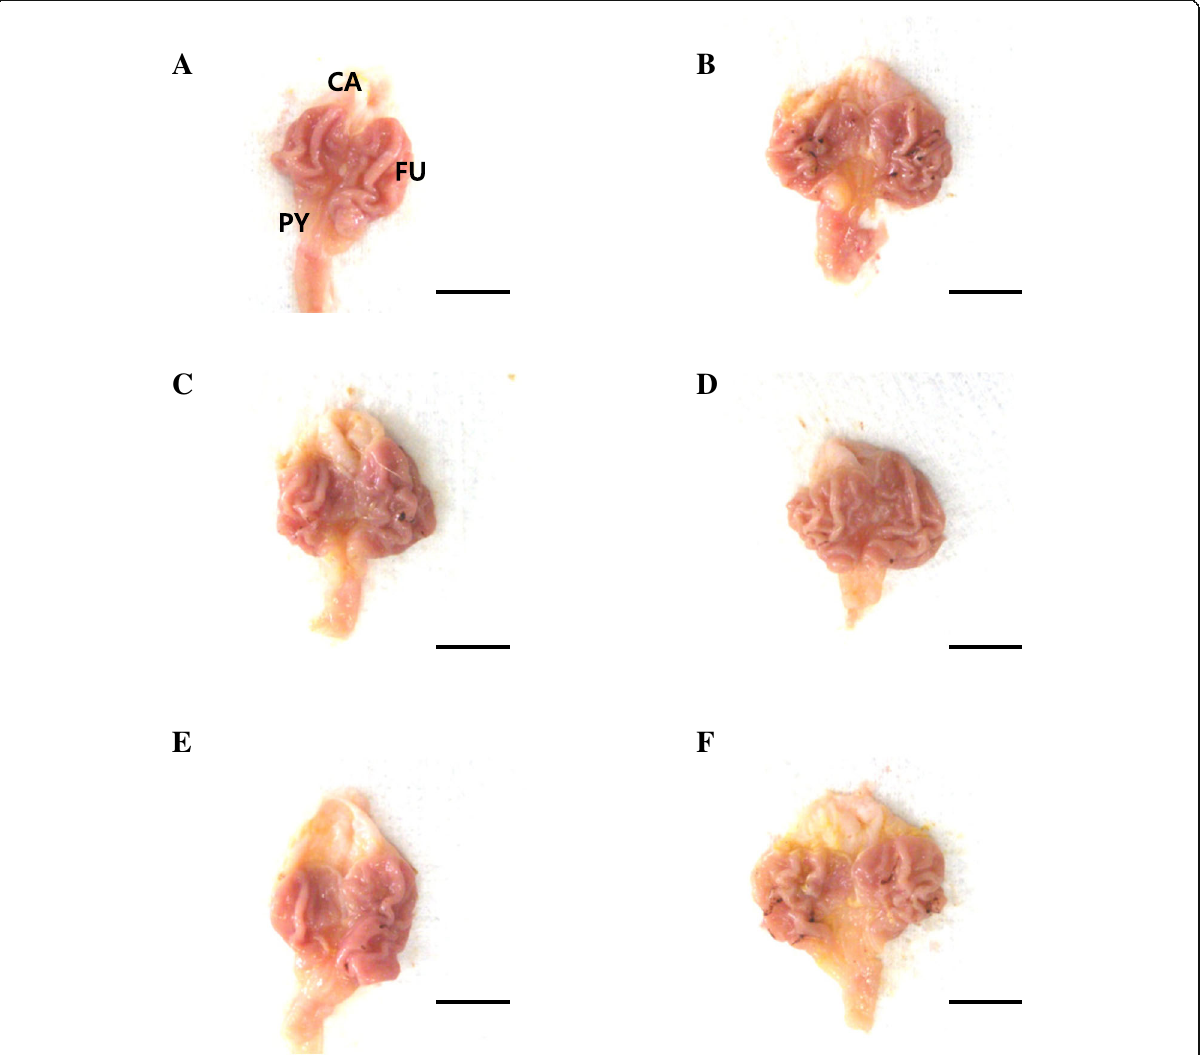
Fig. 2 Representative gross stomach images taken from intact or IND-treated mice. a : Intact control (DW 5 ml kg − 1 , twice administered rats with 30 min-intervals). b : IND control (DW 5 ml kg − 1 and IND 25 mg kg − 1 administered gastric mucosal damage induced vehicle control rats). c : OM (OM 10 mg kg − 1 and IND 25 mg kg − 1 administered reference drug treated rats). d : FBe 300 (FBe 300 mg kg − 1 and IND 25 mg kg − 1 administered the highest dosage experimental rats). e : FBe 200 (FBe 200 mg kg − 1 and IND 25 mg kg − 1 administered the middle dosage experimental rats). f : FBe 100 (FBe 100 mg kg − 1 and IND 25 mg kg − 1 administered the lowest dosage experimental rats). FBe: triple fermented barley extract as test material; DW: Distilled water; IND: indomethacin; OM: omeprazole; CA: cardiac regions of stomach; FU: fundus regions of stomach; PY: pylorus regions of stomach. All test substances were single orally administered, at 30 min before IND 25 mg kg − 1 single oral treatment, and all animals were sacrificed at 6 h after IND treatment. Scale bars = 11